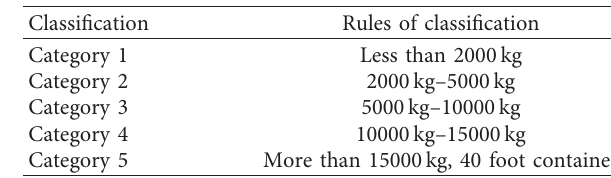
Figure 1: Toll station distribution in Xinjiang. Table 2: New standard goods vehicle classification in JT/T489-